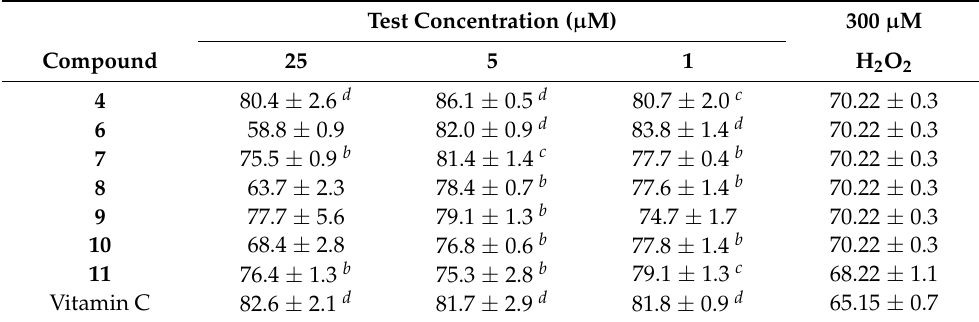
Table 4. Hepatoprotective effects of compounds 4 and 6 – 11 against H 2 O 2 -induced oxidative injury in L02 cells.